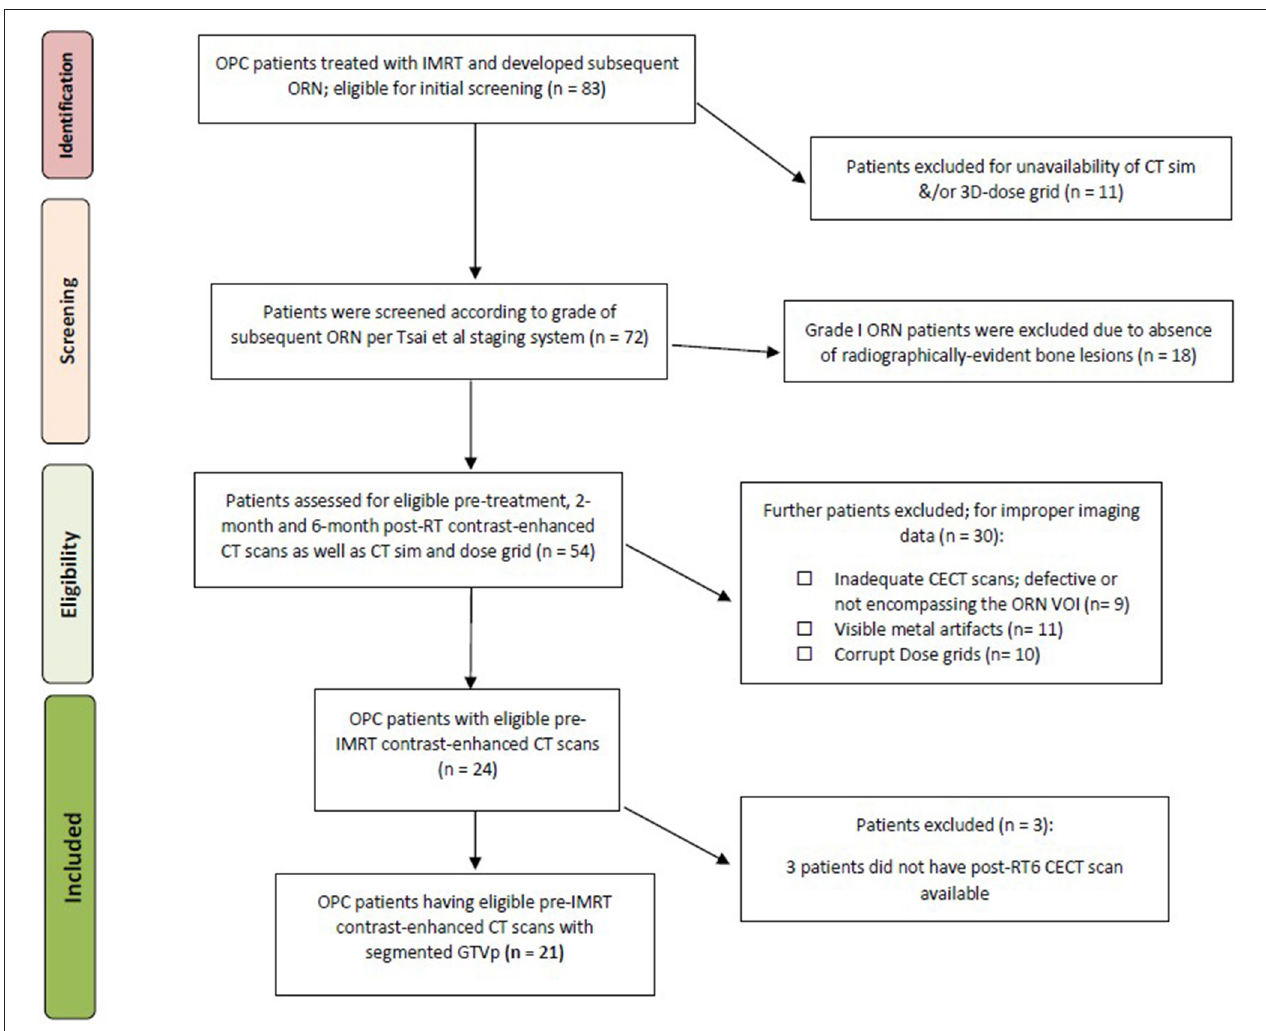
FIGURE 1 | Patient selection. Flowchart of selection process of patients for this